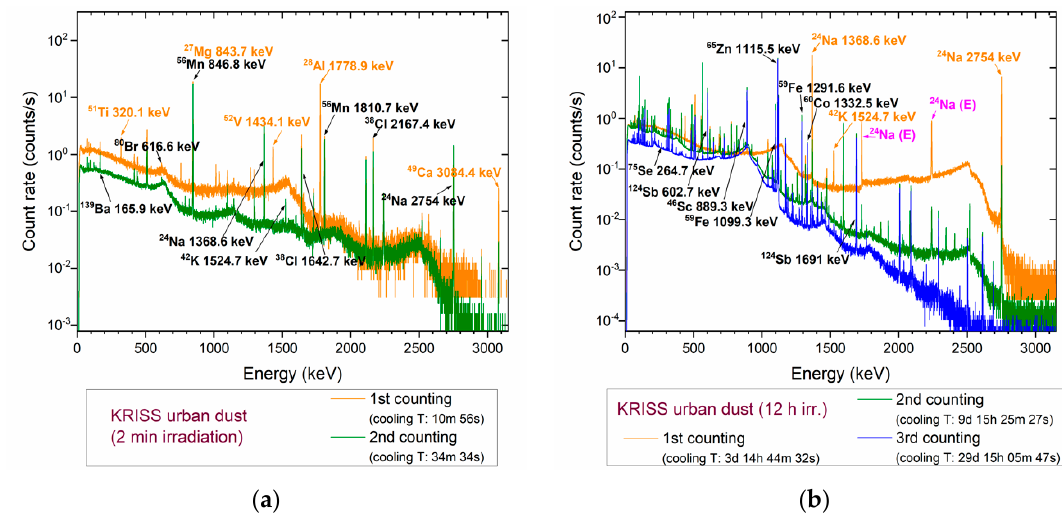
Figure 4. Gamma ‐ ray spectra of KRISS urban dust CRM candidate irradiated for ( a ) 2 min and ( b ) 12 h.